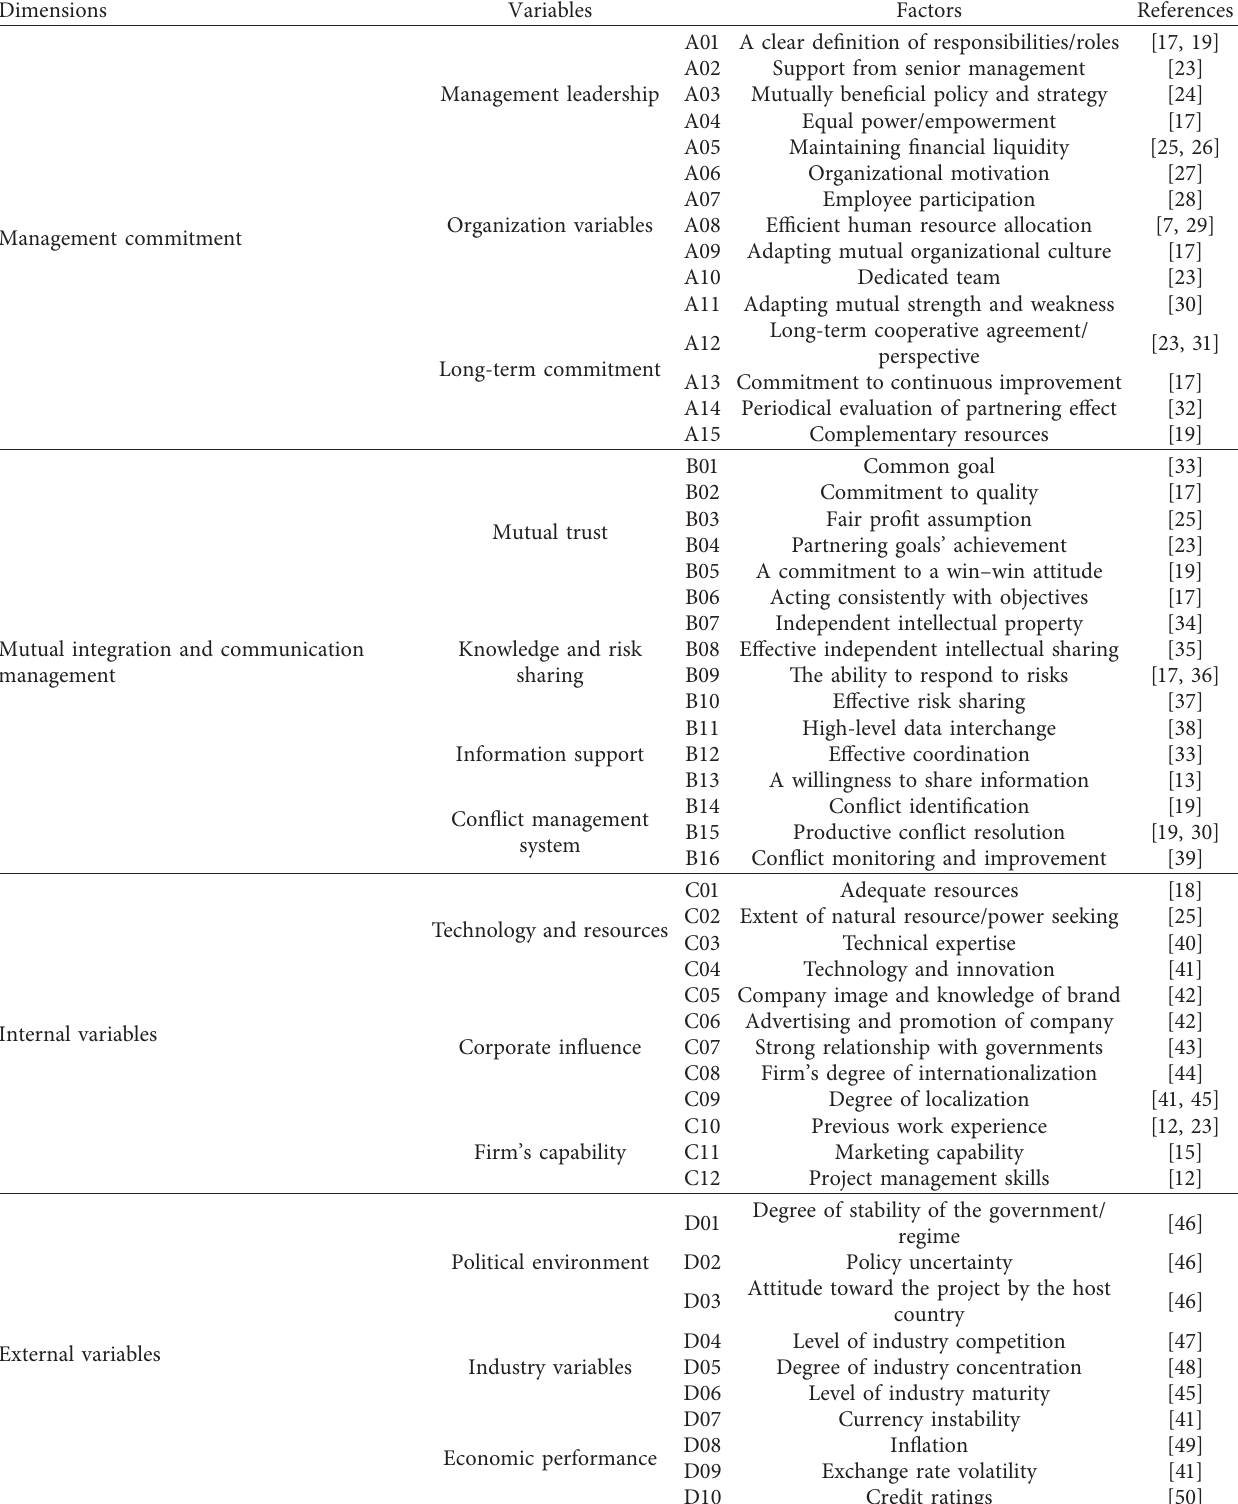
Table 1: Summary of the factors that influence the coopetition relationship in previous